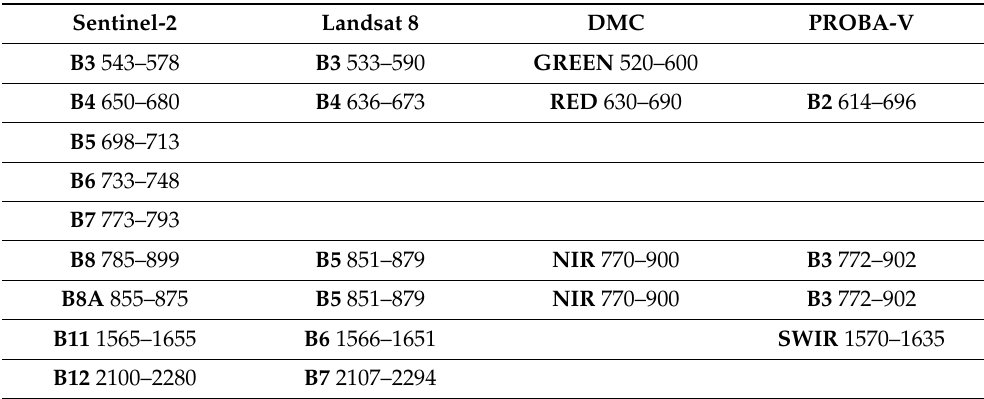
Table 1. Band combinations relative to S2A and their spectral range (in nm).